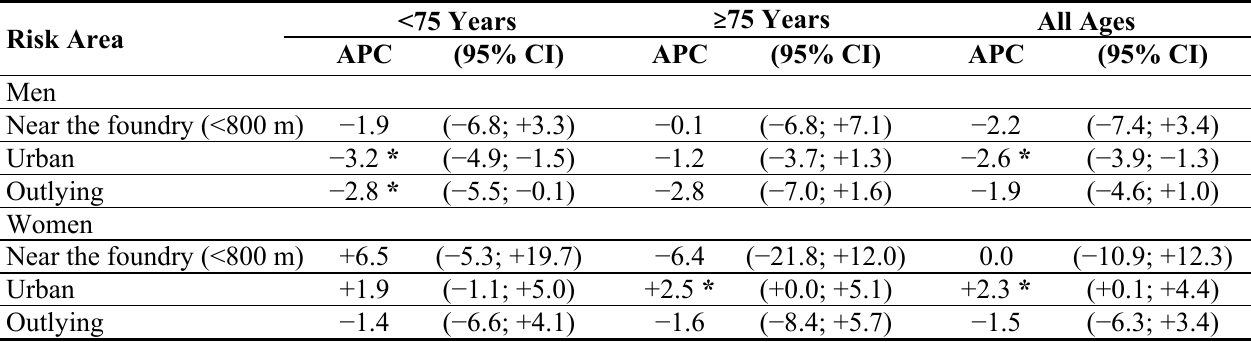
Table 3. Annual percent changes (APC), and corresponding 95% confidence intervals (CI), of lung cancer 1 incidence by sex, and risk area according to age groups during the period 1995–2009 in the municipality of Trieste 2